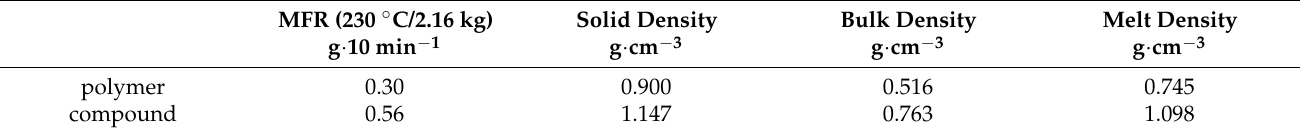
Table 1. Melt flow-rate, bulk density and melt density for the polymer and compound.